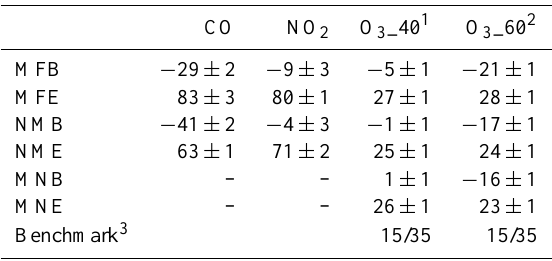
Table 3. Statistical evaluations of CMAQ outputs in comparison to